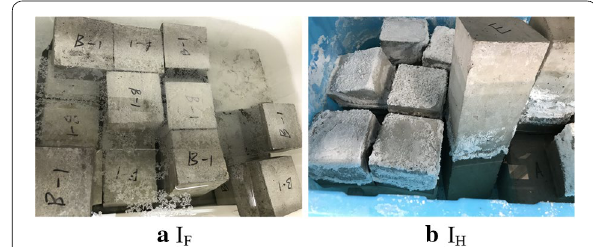
Fig. 1 Specimens from full immersion and half immersion.